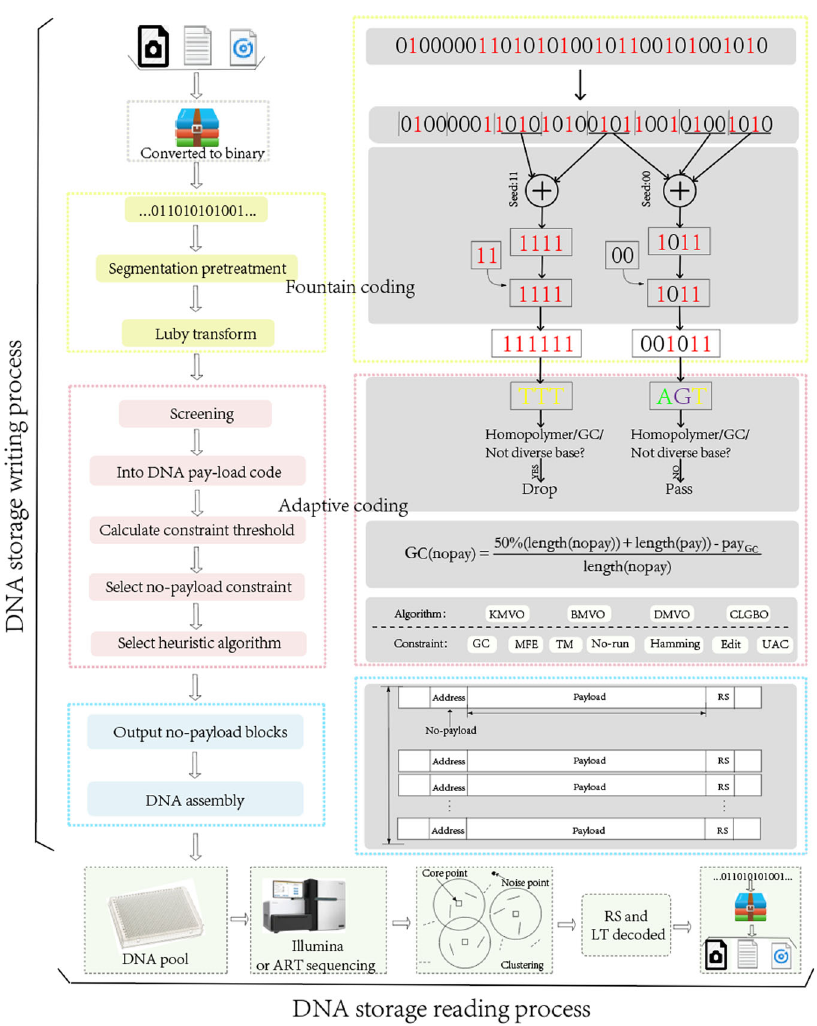
Fig. 6 Process diagram of an adaptive coding for DNA storage